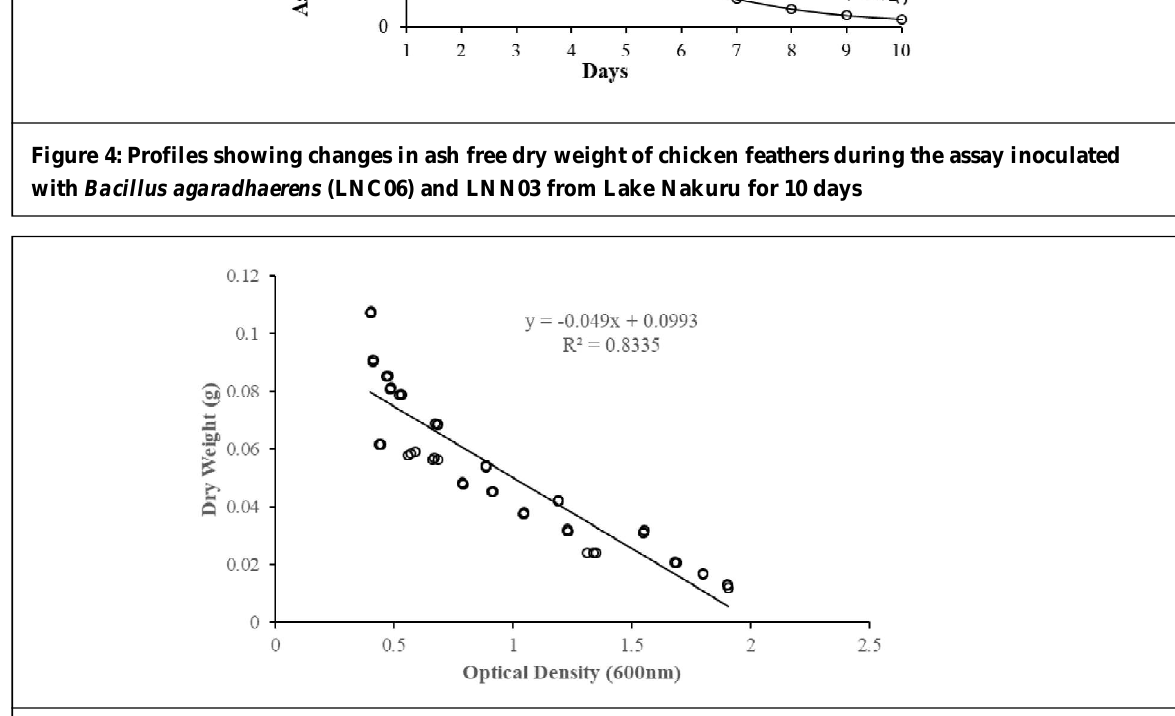
Figure 5: Relationship between optical density (600 nm) and dry weight of chicken feathers